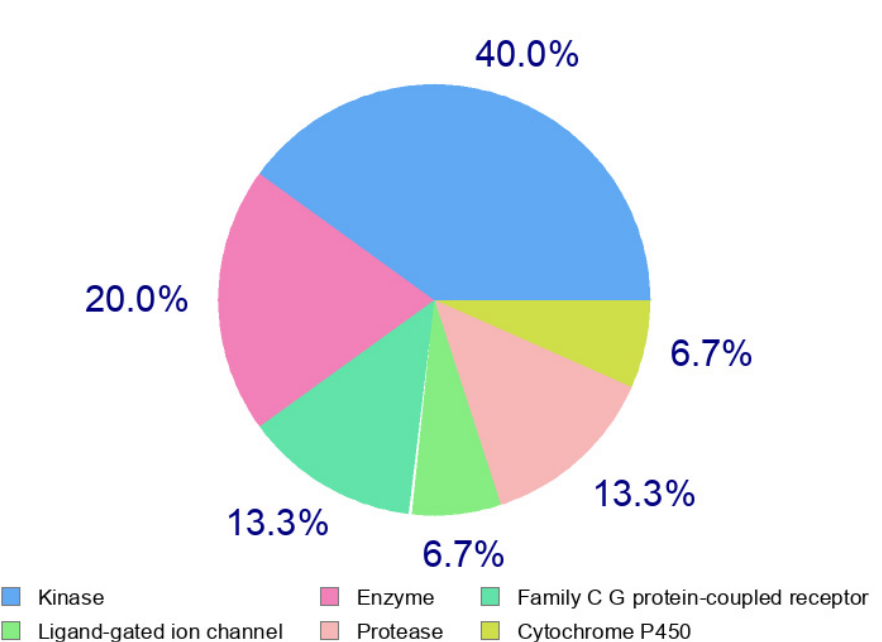
Figure 8. Target prediction for the proposed compounds using Swiss Target Prediction online tool.